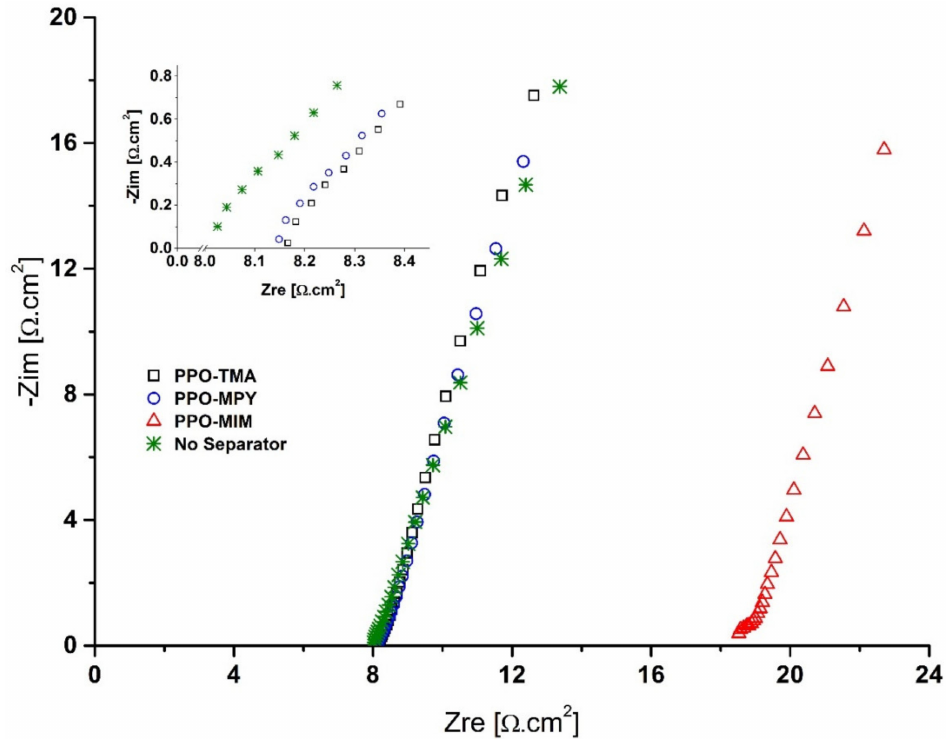
Figure 1. Nyquist plot of EIS for determining ionic conductivity of PPO-based separator membranes. The values of Zre and Zim were obtained by multiplying R b values by the samples’ area (1.766 cm 2 ). 3. Changes in